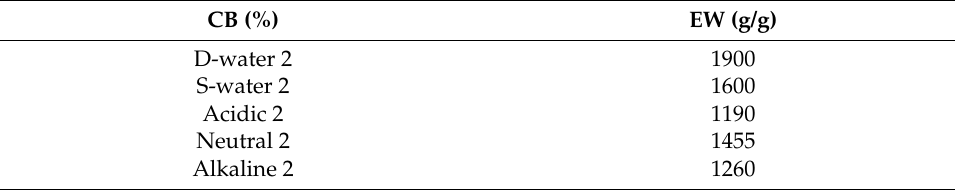
Figure 8. Swelling behavior of the IPNCB composite in different media. Table 6. Swelling behavior of CMC-g-(TerPolys)/CB in various buffer